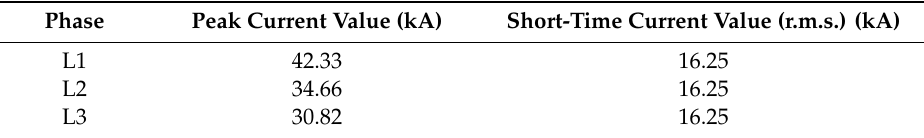
Table 1. Peak current and short-time r.m.s. current for each